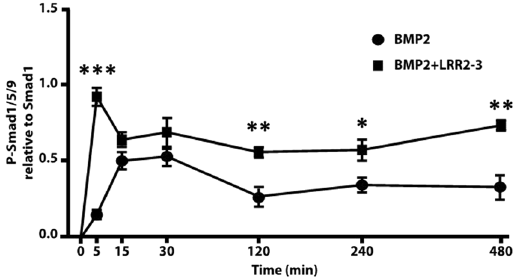
Figure 4. BMP-2 induced Smad phosphorylation. C2C12 cells were treated with 75 ng/mL of BMP-2 alone (closed circle) or BMP-2 with the addition of LRR2-3 (closed square) at various time points. Cell lysates were analyzed for Smad phosphorylation by normalizing phosphorylation (P)-Smad1/5/9 to Smad1. Three independent experiments were performed and values are shown as mean ± S.E. (n = 3). *** p < 0.001, ** p < 0.01, * p <